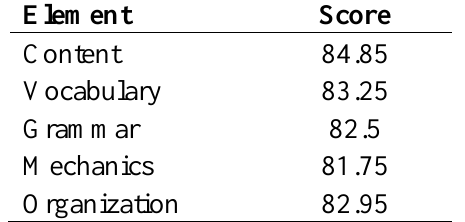
Table 4. Students’ Score of Post Test of Cycle 2 viewed from each Element